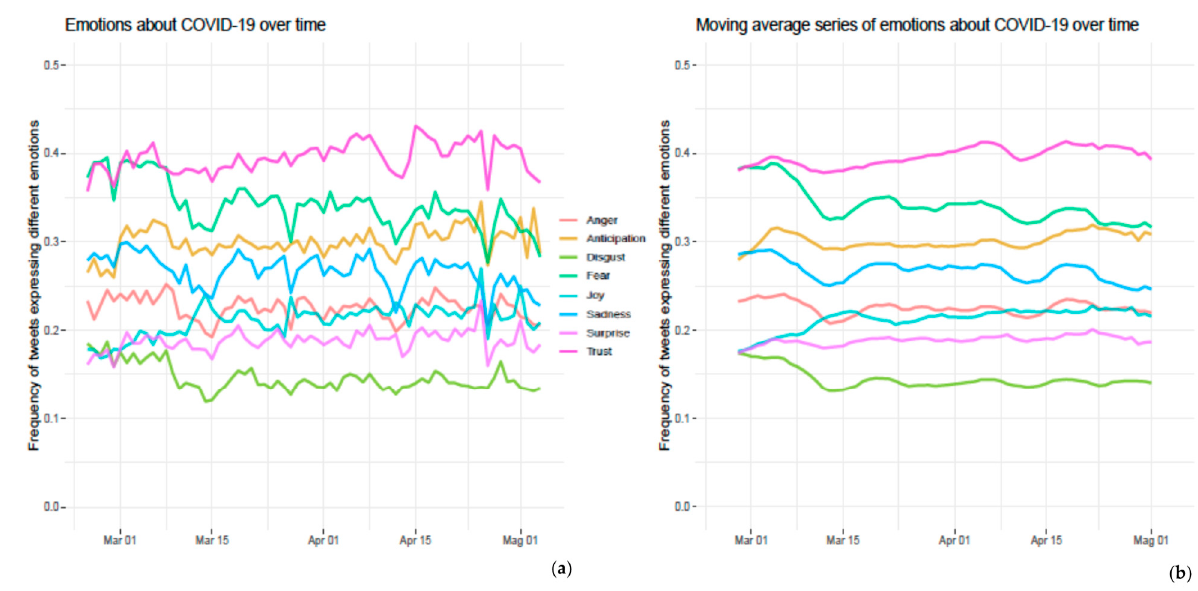
Figure 3. Timeline of emotions over time. ( a ) Daily frequency of tweets expressing different emotions; ( b ) smoothed series obtained using simple moving average (MA) based on 7 days to remove peak and the “weekend effect”.